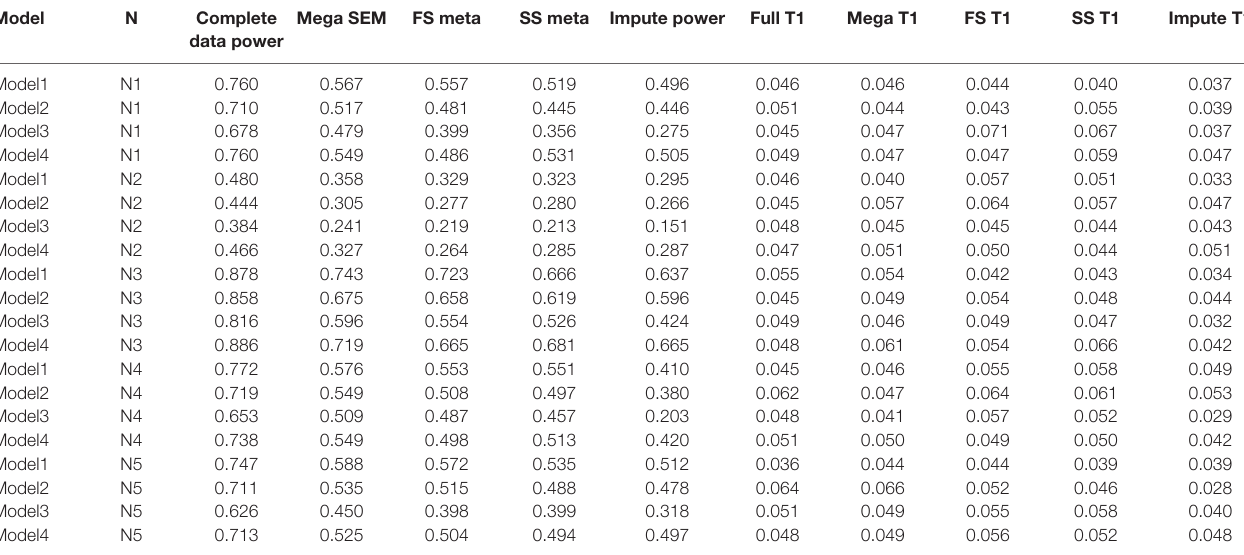
TABle 2 | Empirical power and type I error results with different analysis methods under the four data-generating models and five sample size conditions. Model